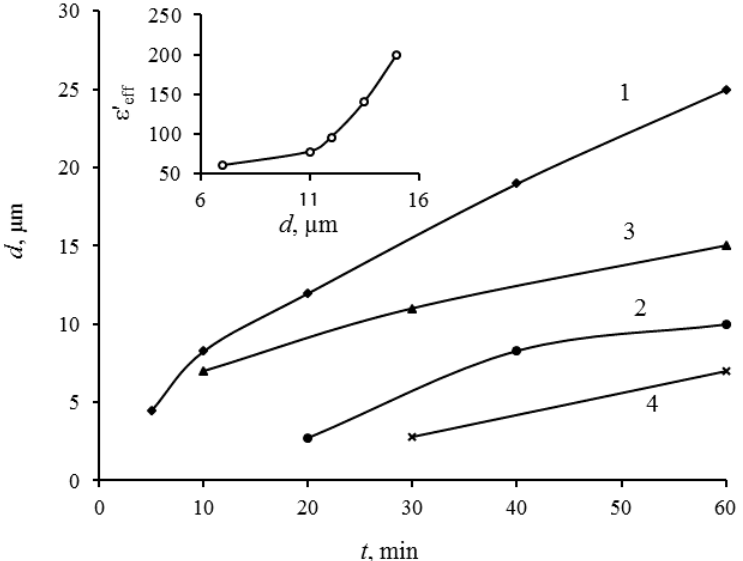
Figure 1. Kinetic dependences of growth of thickness of the film composite coating for various manufacturing modes. 1— ∆ t = 30 min, n = 6%, manual method; 2— ∆ t = 30 min, n = 12%, manual method; 3— ∆ t = 20 days, n = 6%, manual method; 4— ∆ t = 20 days, n = 6%, centrifugation. On the inset: dependence of effective dielectric constant of composite on the film